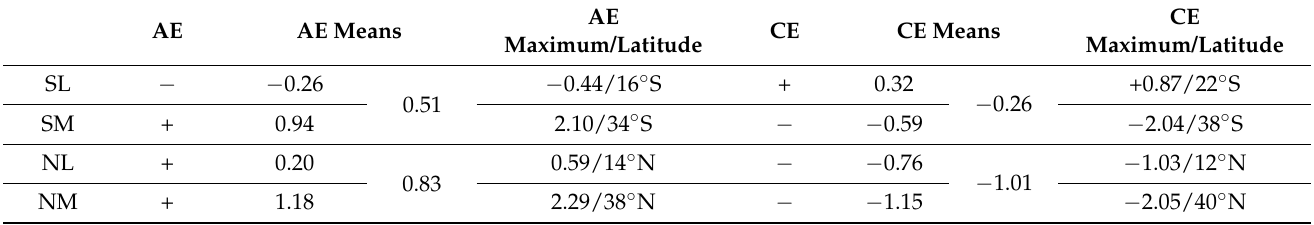
Table 2. ZEU′ statistics table.